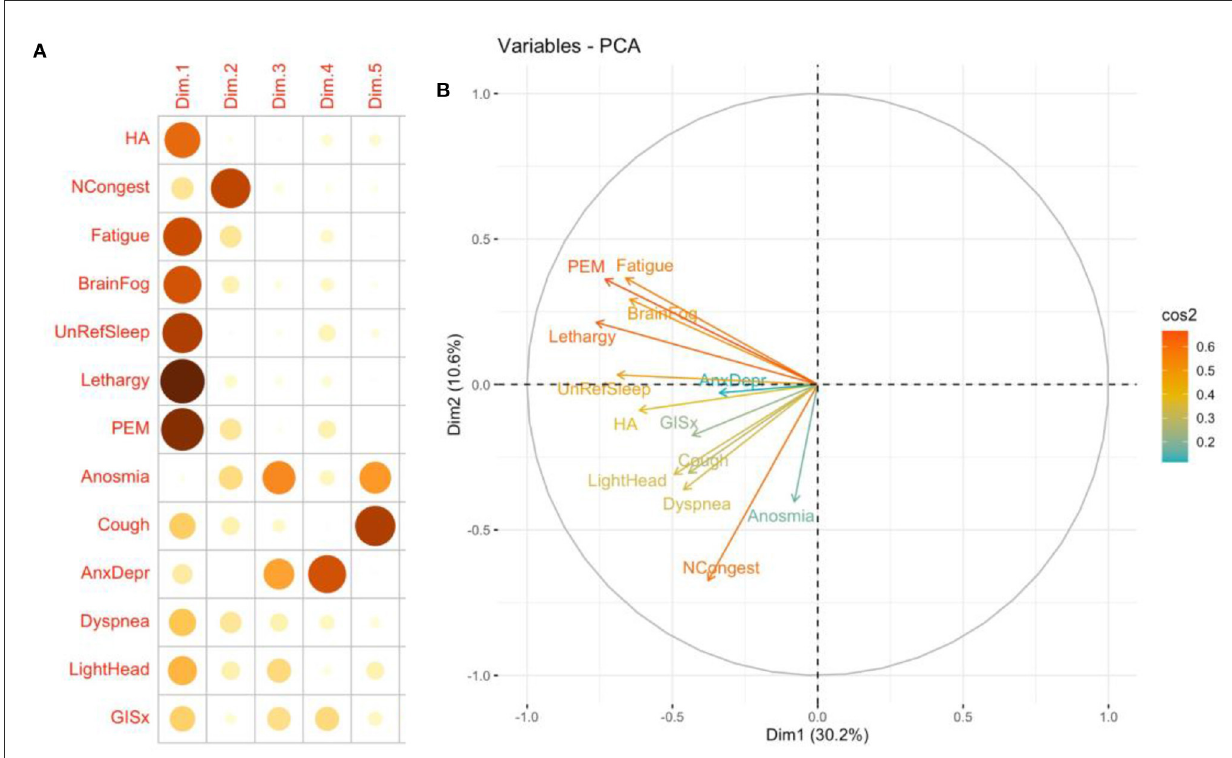
FIGURE3 Quality of representation of 13 most common symptoms mapped to the first five dimensions (A) and principal components analysis correlation circle (B) . Insomnia and ageusia were not included in the analysis. The closer the variable to the correlation circle, the better the representation on the factor map. The quality of the representation of the symptom on the first five dimensions is measured by the squared cosine between the symptom vector and its projection on the dimension. The proportions on the left side of the factor map represent a color scale (14). CP, Chest pain; GISx, Gastrointestinal symptoms; Anex/Depr, Anxiety/Depression; HA, Headache; Lethargy, daytime sleepiness; UnRefrSleep, Unrefreshed sleep; PEM, Post-Exertional